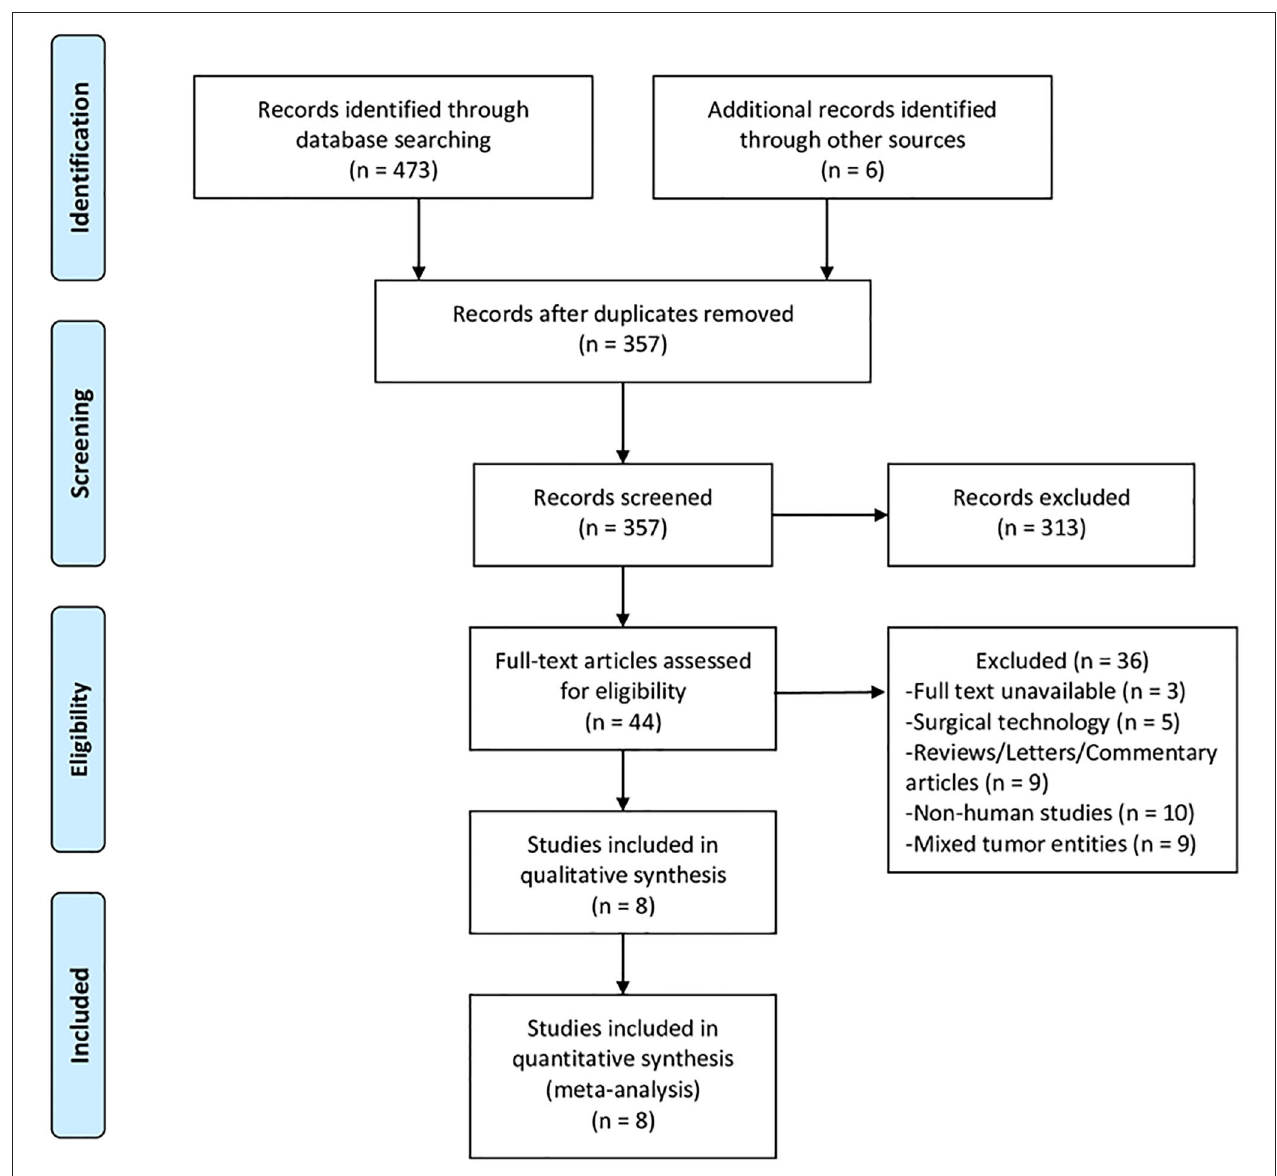
FIGURE 1 | PRISMA flow diagram depicting the selection process of studies included for